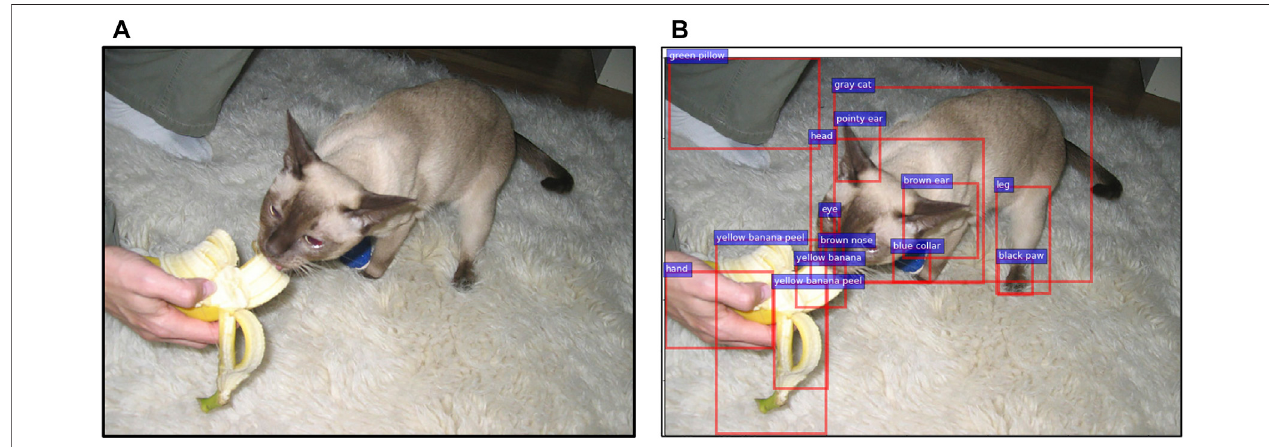
FIGURE 2 | Example of object detection output from the MSCOCO dataset. The original image (A) and a subset of the detected objects represented by bounding boxes, labels and attributes (B) . The caption for the original image: “ a cat that is eating some kind of banana ”